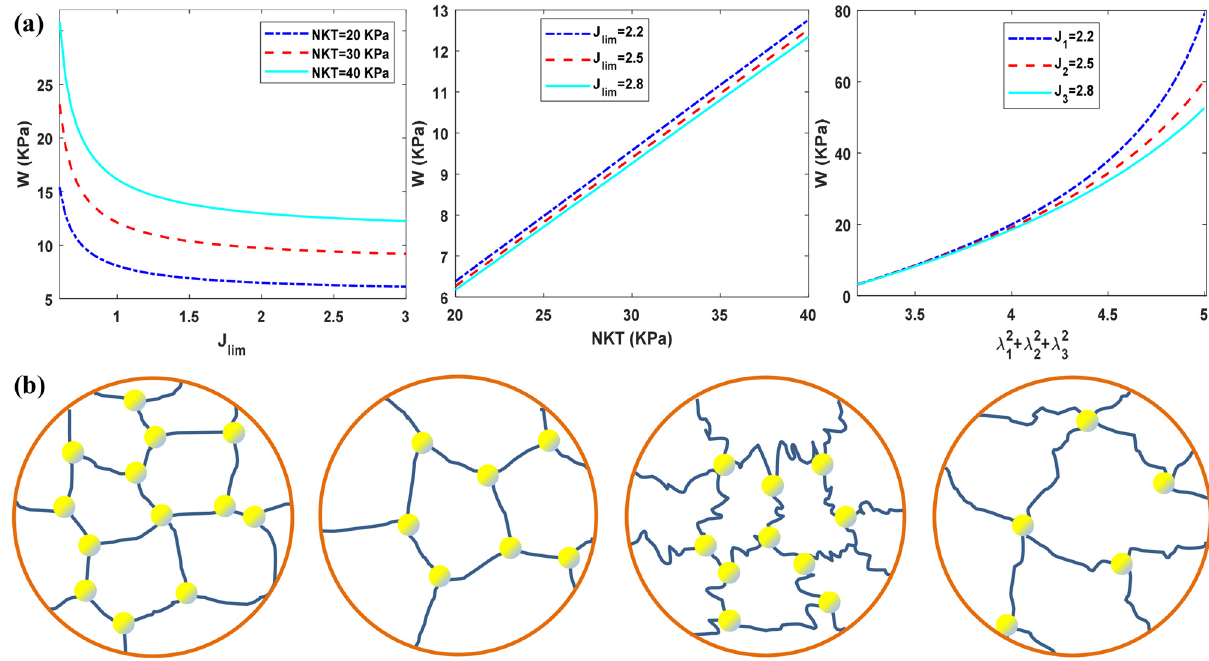
Figure 4: The change of free energy density and microcondensation of the cone